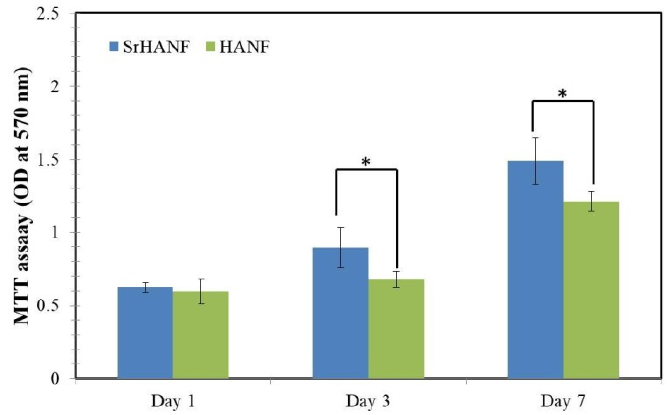
Figure 5. Quantification of MG63 osteoblast-like cells on SrHANF and HANF matrices. MTT assay quantifying cell proliferation on SrHANF and HANF. The viability of MG63 osteoblast-like cells on various matrices after culture for up to seven days. Data are presented as the mean ± SD, n = 3. Statistical analysis comparing SrHANF and HANF. (*) Denotes a significant difference ( p < 0.05).